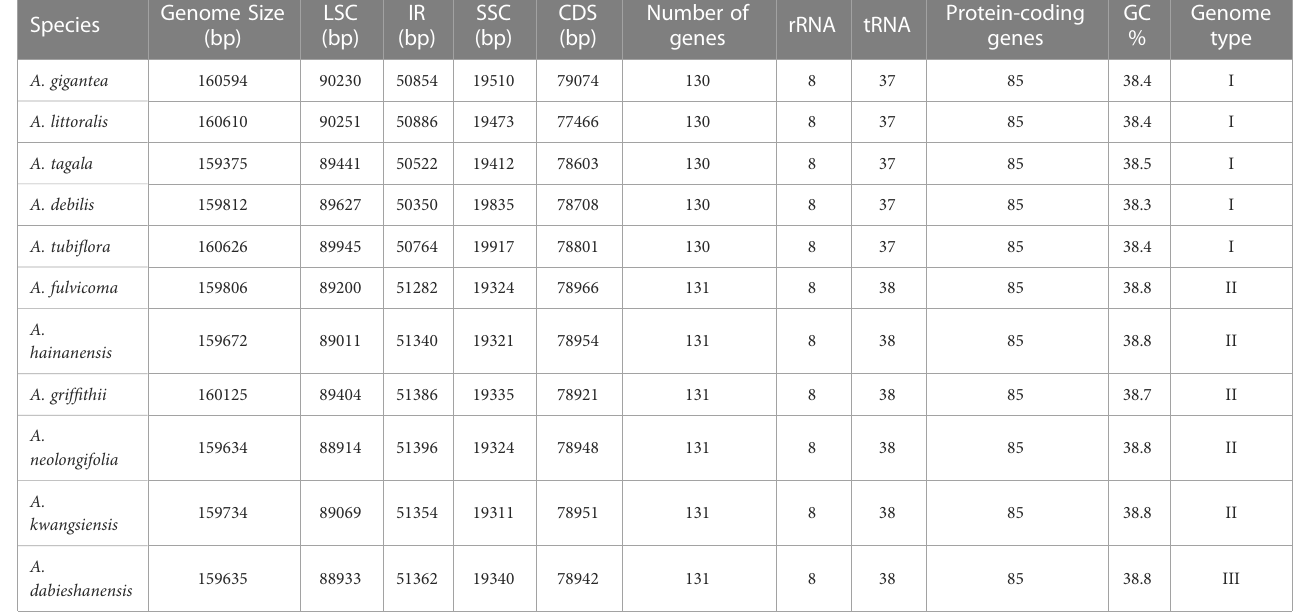
TABLE 1 Genome structure of complete chloroplast (cp) genomes of Aristolochia species. Species